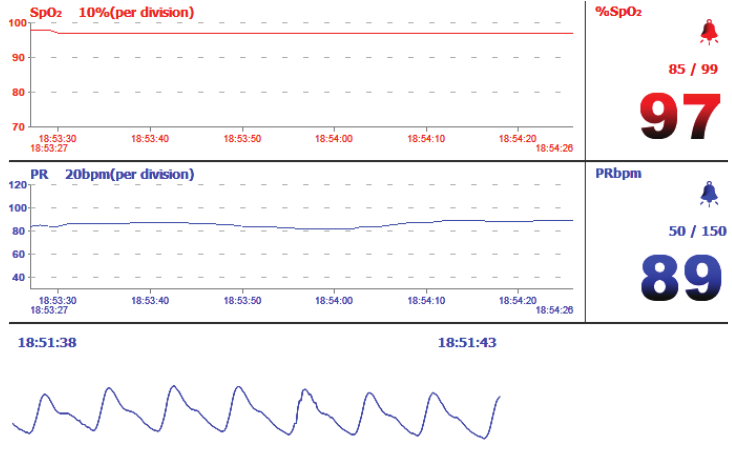
Figure 16. S P O 2 analysis software display results.